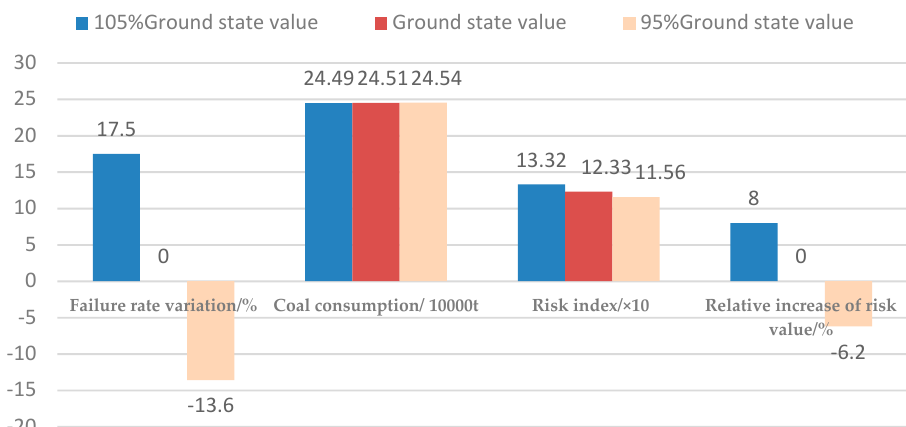
ff erent forecasting wind